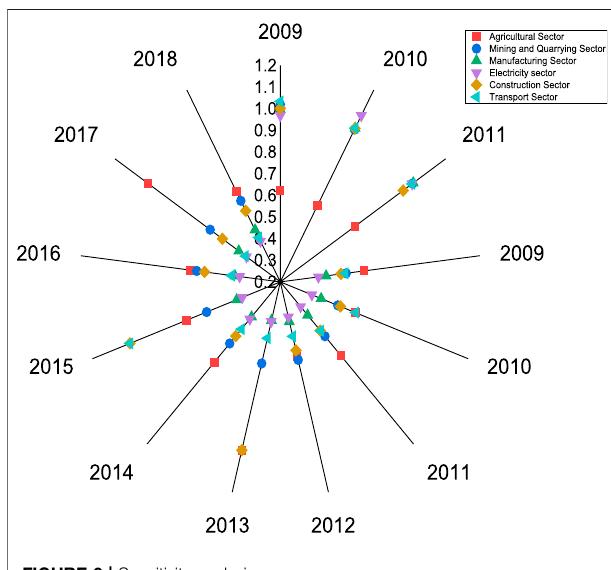
FIGURE 9 | Sensitivity